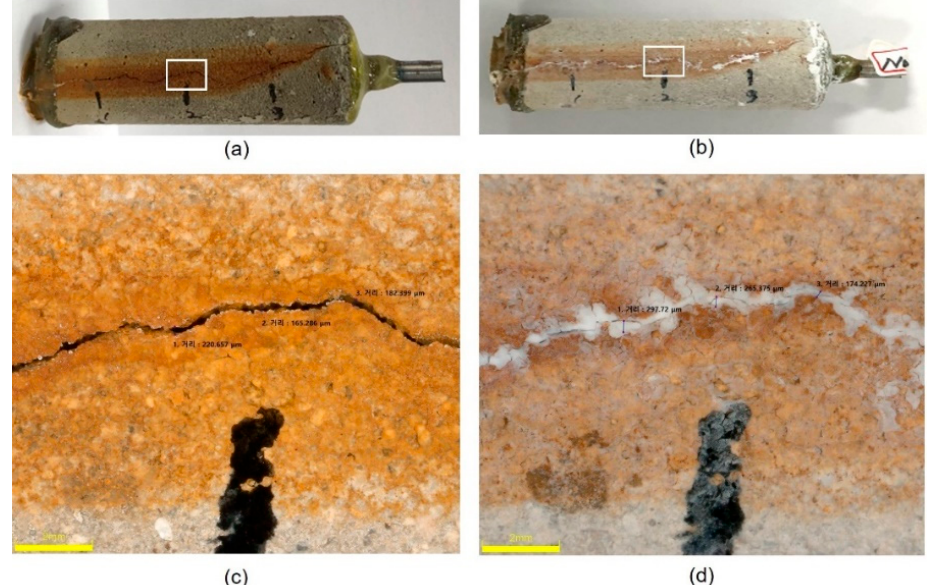
Figure 11. Optical microscope images of a surface-breaking crack formed in the concrete sample TP3-1: ( a ) before and ( b ) after being rehabilitated by EDT process, respectively, and ( c , d ) enlarged images in the region of interests pointed out by the white rectangular symbol in Figure 11a,b, respectively. Figure 12a–d show the optical images of the cross-sections of the four concrete samples after being treated by four different EDT processes, TP3-1, TP3-2, TP-3-3, and TP3-4, respectively. Precipitation of magnesium ions appeared around the mouth of surface- breaking crack and continued to the tip of the cracks along the crack interface. Cross section image shows that the precipitation of magnesium formed in the porous corrosion products, which would become a barrier to decrease the diffusion rate of dissolved oxygen and external harmful materials and thus suppress the corrosion rate. Figure 13a show the SEM image of the cross-section of a concrete sample at the tip of a surface-breaking crack (TP3-3). Equivalent elemental maps are shown in Figure 14b–f, representing distribution of O, Fe, Si, Ca, and Mg, respectively. The cross-section of a reinforcing steel is characterized by high Fe and low oxygen concentration, while the concrete cross-section is characterized by low Fe and high oxygen. The cross-section of the crack is presented as the region with high magnesium concentration. The cross-section images and the elemental maps demonstrate that precipitation of magnesium ions formed at the tip of a surface-breaking crack on the steel and concrete interface, which would improve the corrosion resistance of reinforced